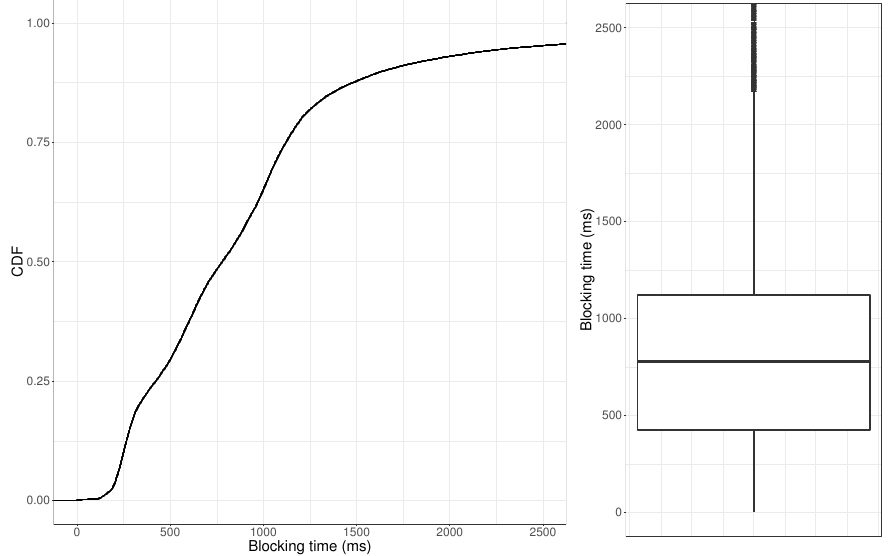
Figure 5. CDF ( left ) and boxplot ( right ) that represent the time our solution requires to block ads. The depicted results are obtained from a subset of 40 K